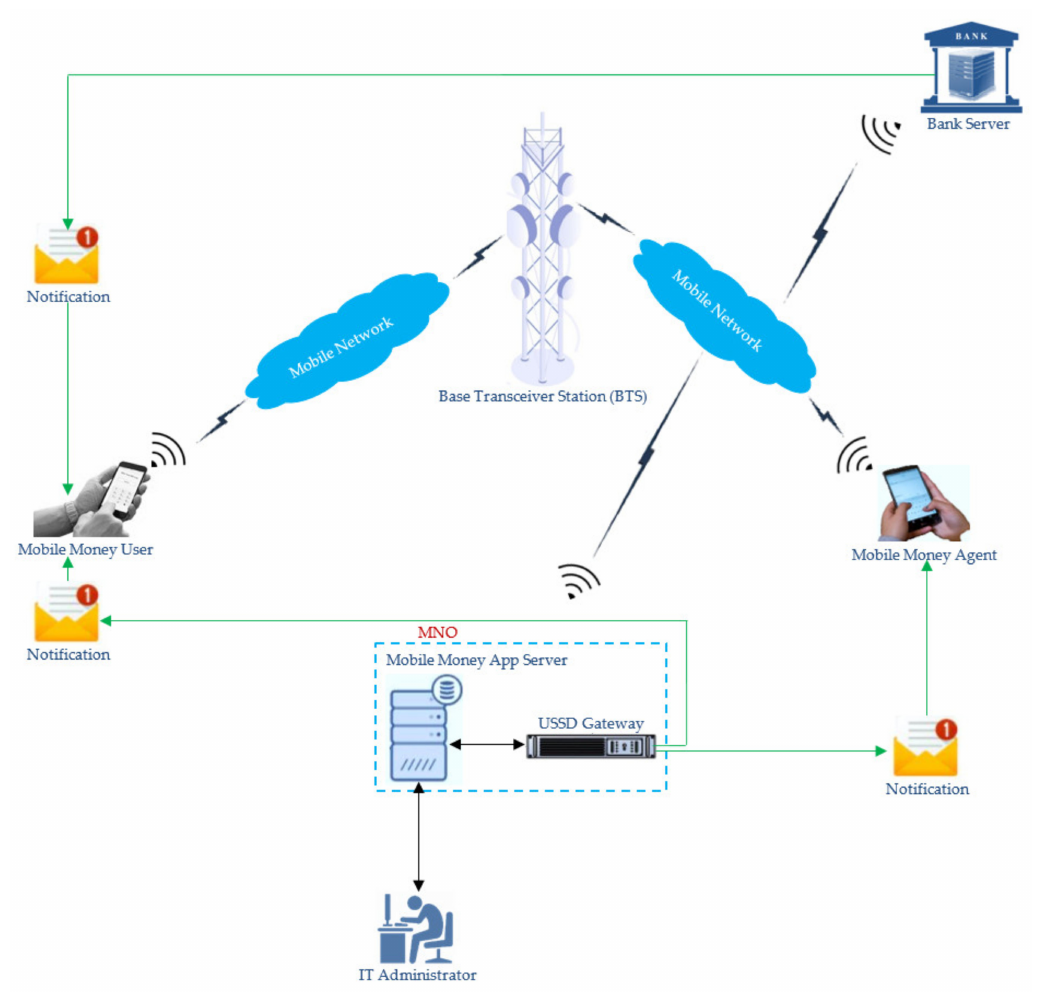
Figure 1. Mobile money system (MMS)